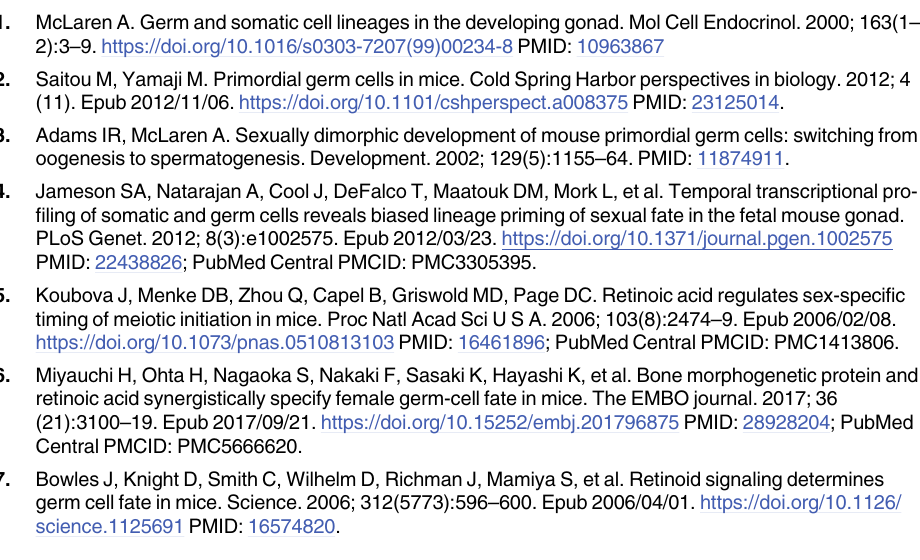
S1 Table. Oligonucleotide sequences for primers and gRNAs used in this study. S2 Table. Antibodies used in this